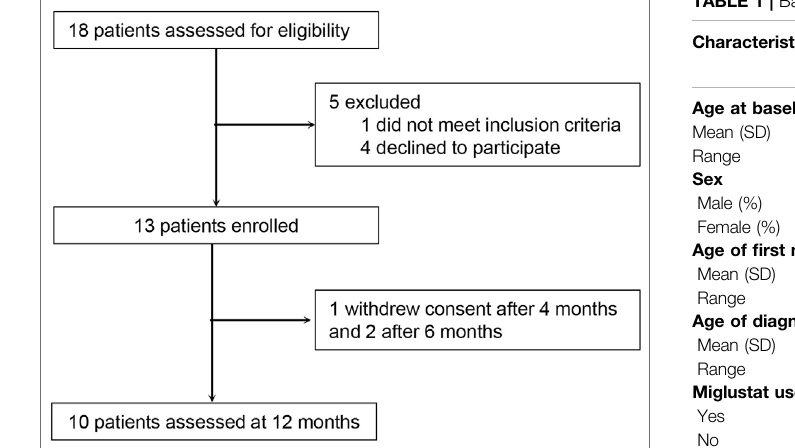
TABLE 1 | Baseline characteristics of patients.